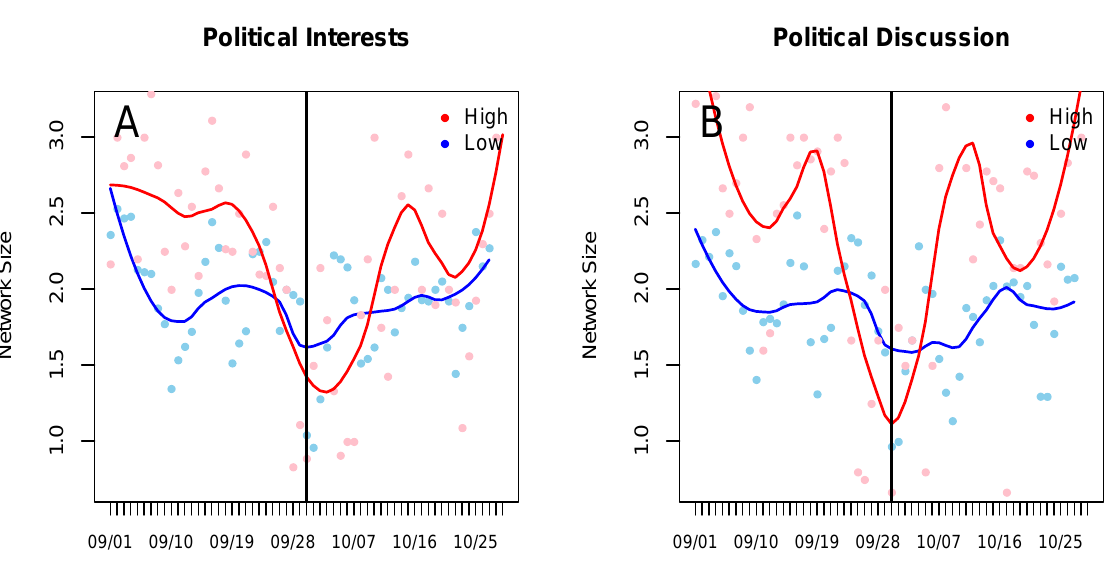
Figure 4: The interaction effects of priming with political engagement at the individual level. Note: Each circle represents the mean network size for the three days around each survey date (t-1,t,t+1), and each line shows the loess curve estimated by the loess function in R package with smoothing parameter ( α ) set to 0.4 depending on each category; Political Interest is dichotomized into High (very interested) and Low (rest); Political Discussion is dichotomized into High (discuss politics often) and Low